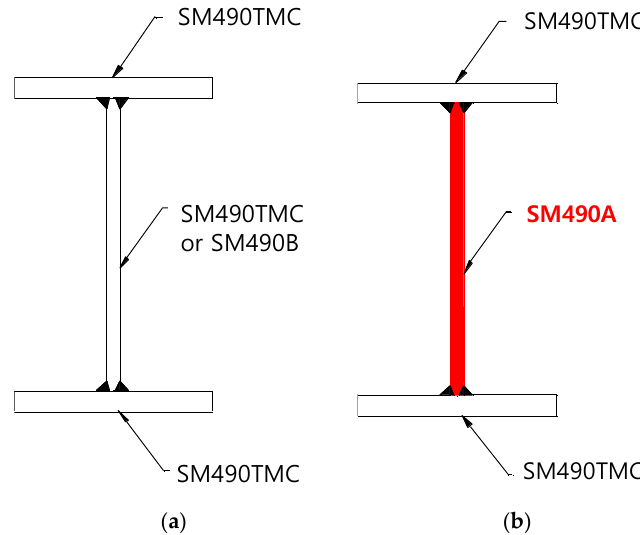
Figure 1. Section of built-up wide flange steel beam. ( a ) Typical type; ( b ) proposed type. Metals 2019 , 9 , x FOR PEER REVIEW